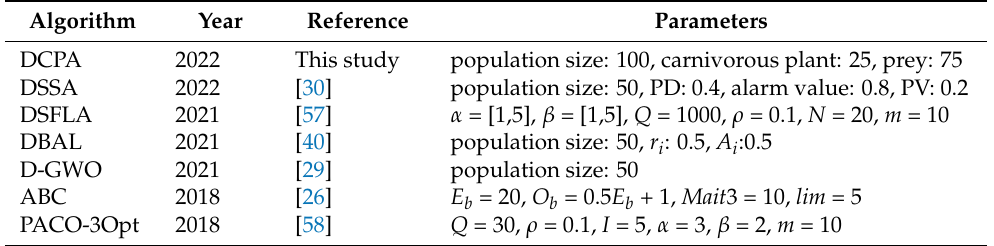
Table 14. Parameter settings of